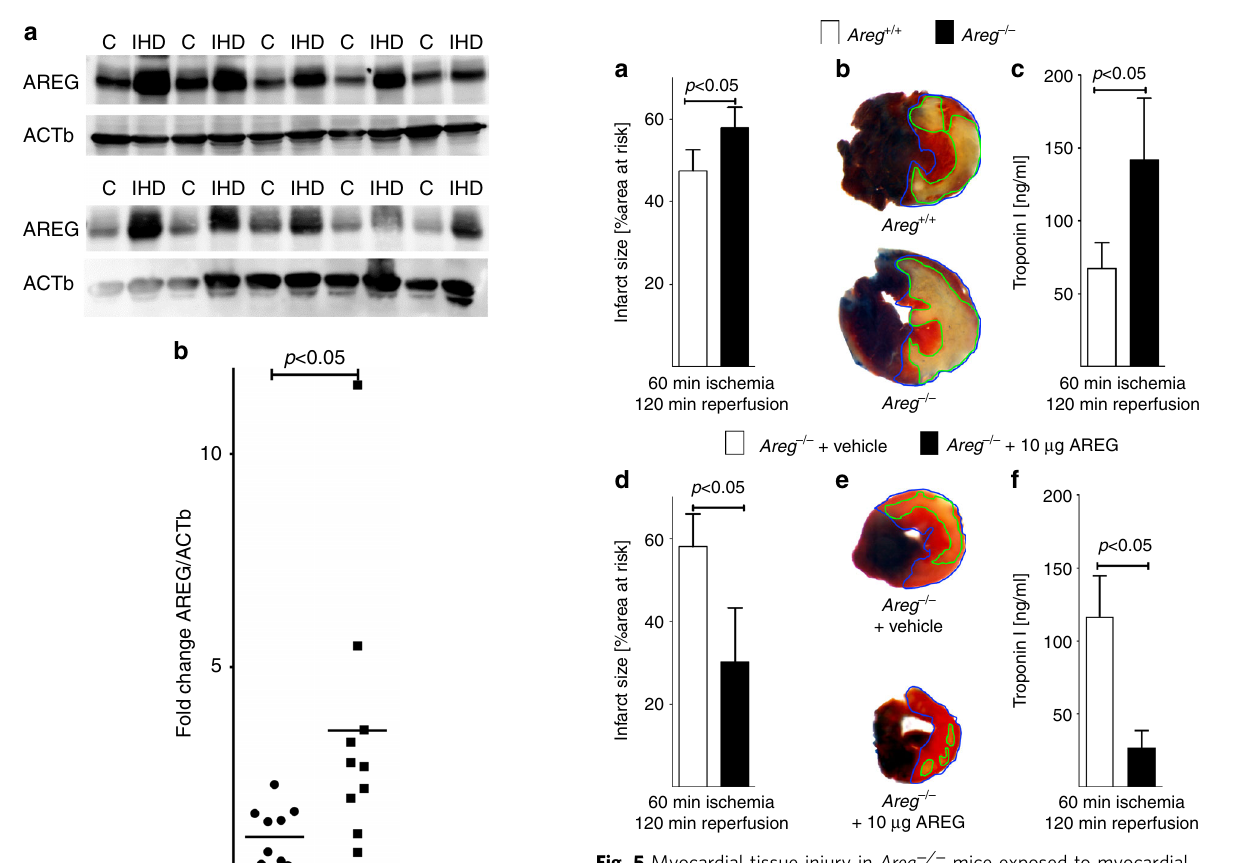
of Areg − / − mice via intravascular infusion of murine recombinant Areg reduced ischemic myocardial tissue injury, including smaller infarct sizes (Fig. 5d, e) and attenuated release of troponin I (Fig. 5f). Together, these fi ndings suggest that genetic deletion of Areg increases myocardial tissue injury following murine ische- mia and reperfusion injury, while reconstitution with 10 µ g recombinant Areg can rescue the phenotype of Areg − / − mice.